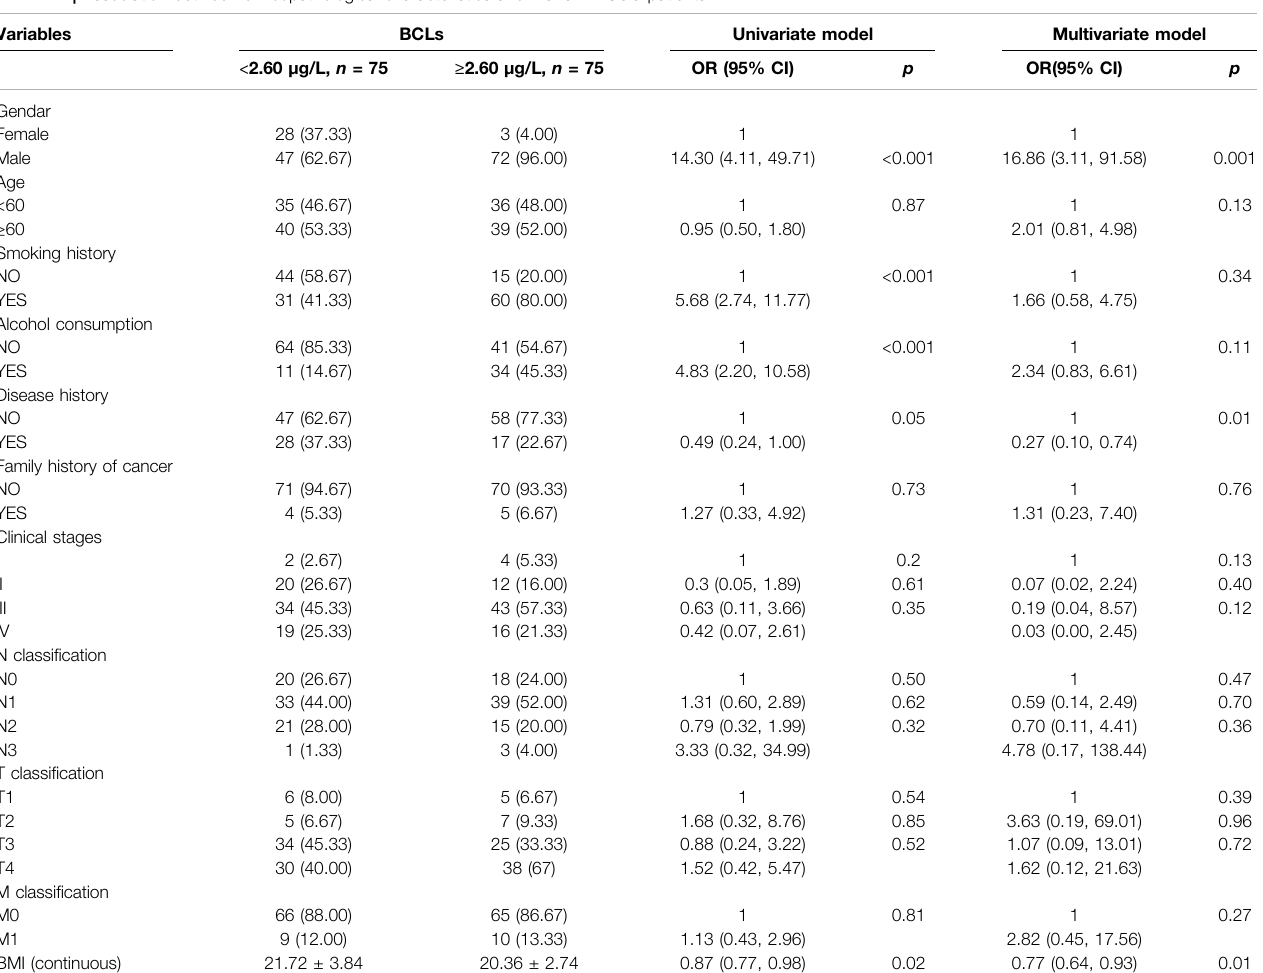
TABLE 2 | Association between clinicopathological characteristics and BCLs in ESCC